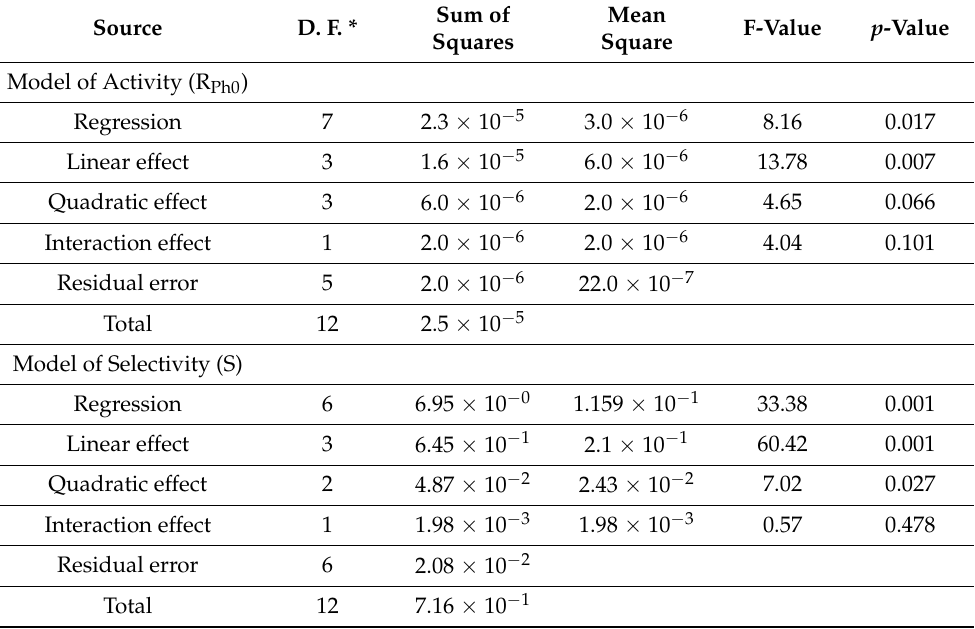
Table 3. Analysis of variance (ANOVA) for second-order models (95% probability).